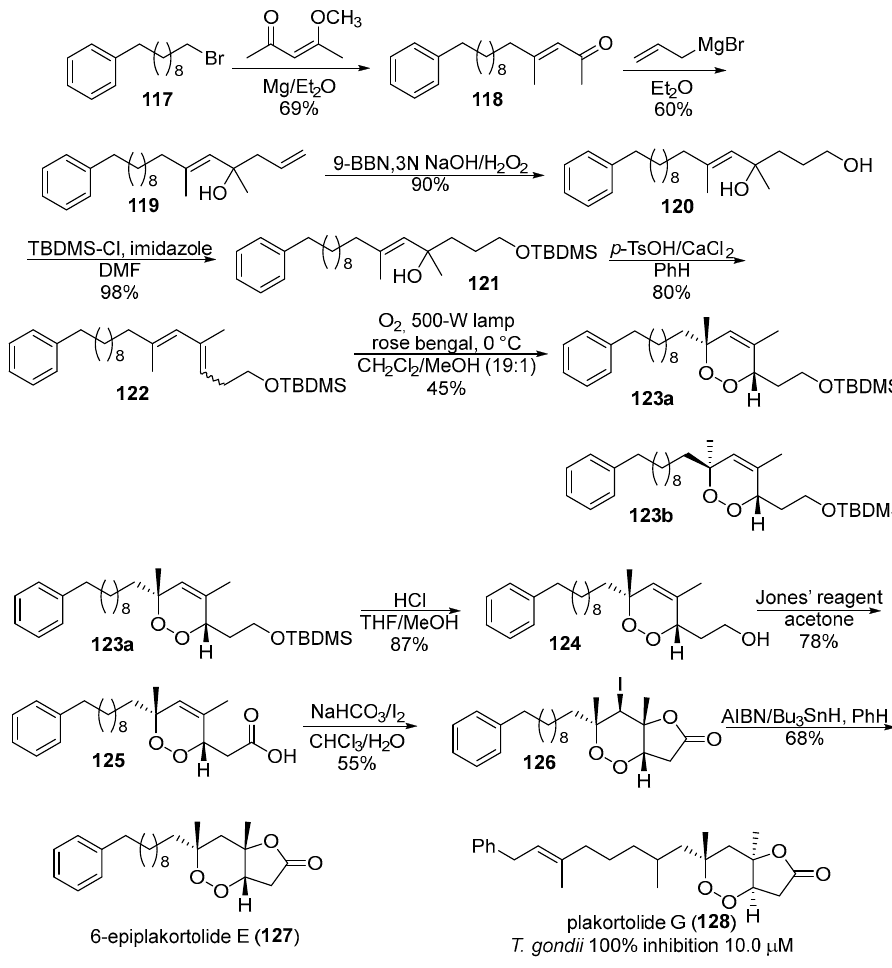
Scheme 20. Synthesis of 6-epiplakortolide Е ( 127